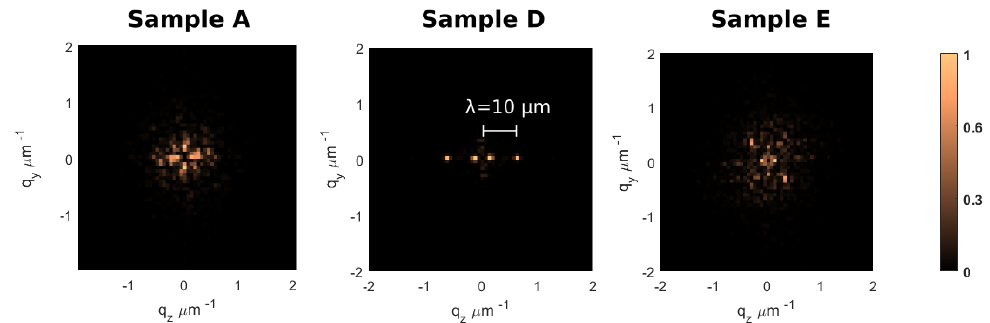
Figure 1. Two-dimensional power spectral densities (PSD) of three samples before thermal annealing. Sample A was written with standard parameters. Sample D had the coarser z spacing (dz). Sample E was written with standard parameters but with parallel linear polarization. Each plot is normalized with respect to its